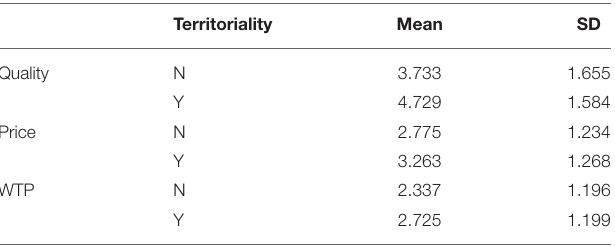
TABLE 1 | Descriptive statistics of quality, price, and WTP in relation to territoriality.